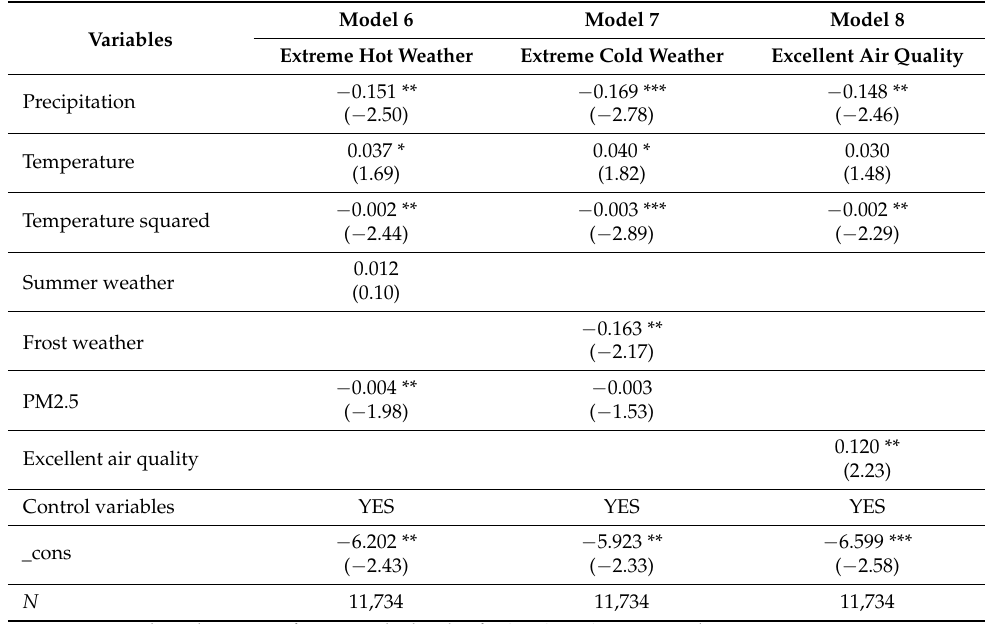
Table 4. The effect of extreme climate conditions on elderly migrants’ settlement